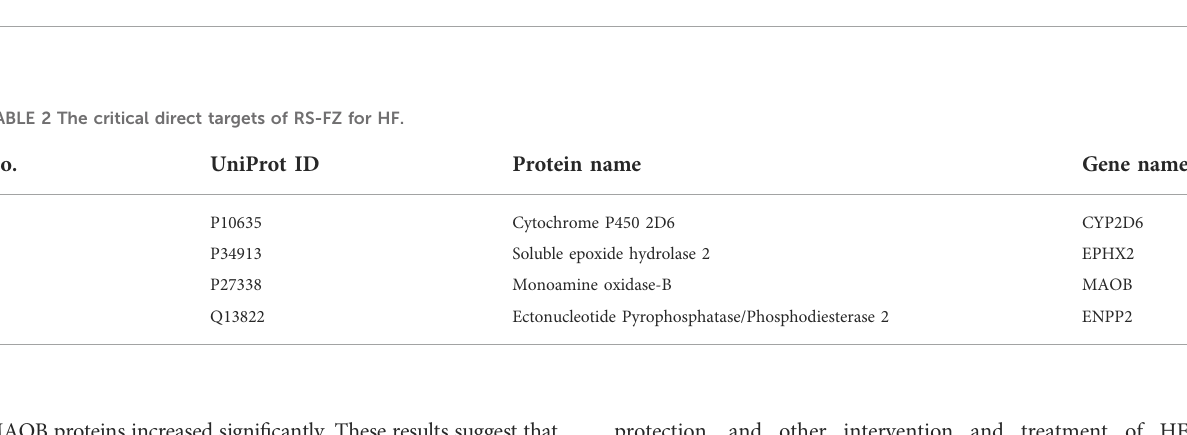
FIGURE 6 The “ Metabolite-Target-Component ” interactive network participates in the treatment of HF by RS-FZ. The green diamonds represent active components of RS-FZ. The red triangles represent the speci fi c metabolites. The blue dots represent common targets of RS-FZ components and speci fi c metabolites (Yellow dots represent the critical targets that have been validated by immunohistochemistry).